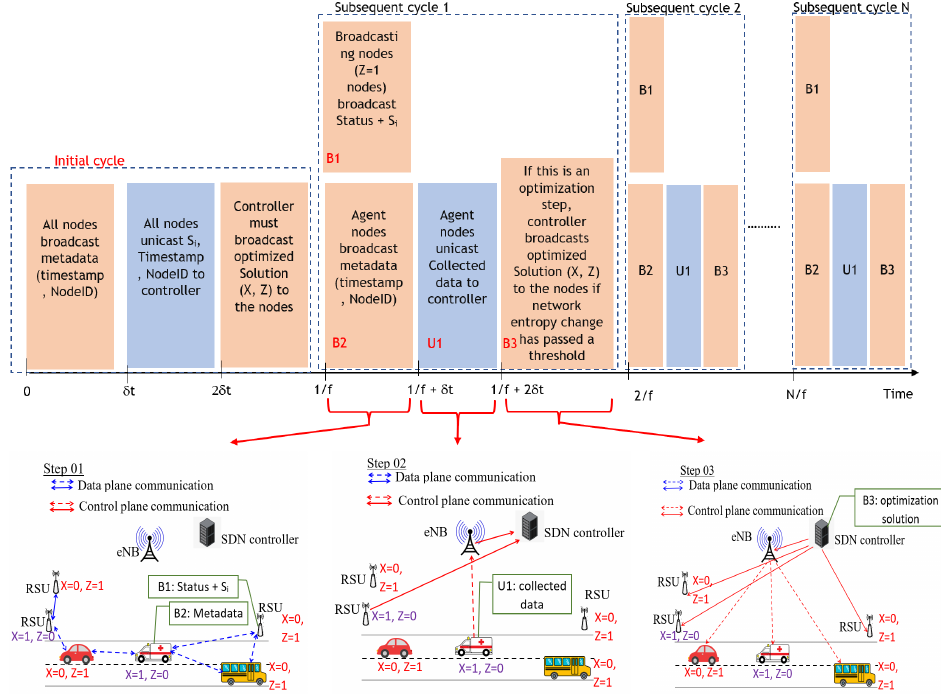
Figure 1. The process of status data, metadata, and optimization solution transferring in each data gathering